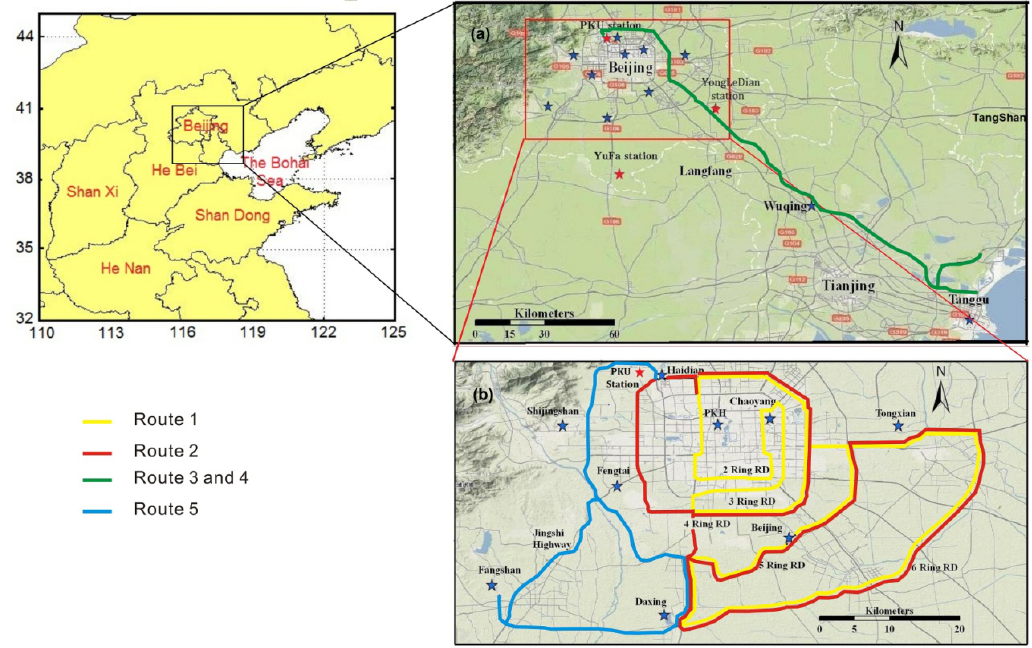
Fig. 1. Maps of the mobile monitoring areas in CAREBeijing-2008. The green track in (a) shows route 3 and 4 in Table 1. The red, yellow and blue tracks in (b) show the route 1, 2 and route 5 respectively. The red stars on the maps represent the stationary sites on SO 2 measurements and the blue stars show the CAMS meteorological